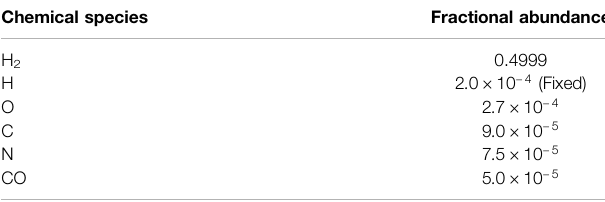
TABLE 1 | Initial gas-phase abundances as a fraction of total hydrogen. Chemical